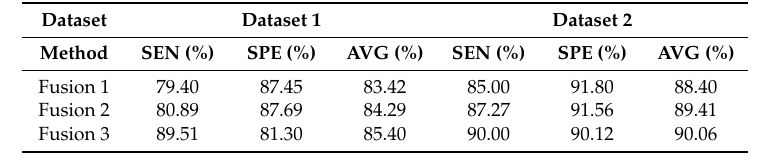
Table 2. Classification outcomes of all the fusion schemes.